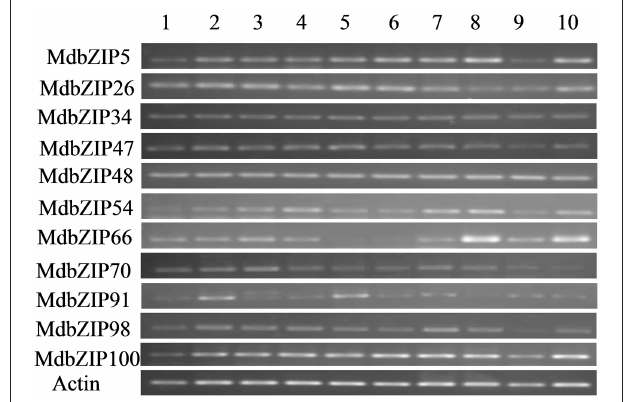
FIGURE 6 | Expression analysis of the 11 MdbZIP genes from group A in various organs, as determined by semi-quantitative RT-PCR analyses. Organs are indicated as follows: 1-roots, 2-stems, 3-apical buds, 4-flower buds, 5-young leaves, 6-mature leaves, 7-young fruits, 8-seeds of young fruits, 9-mature fruits, 10-seeds of mature